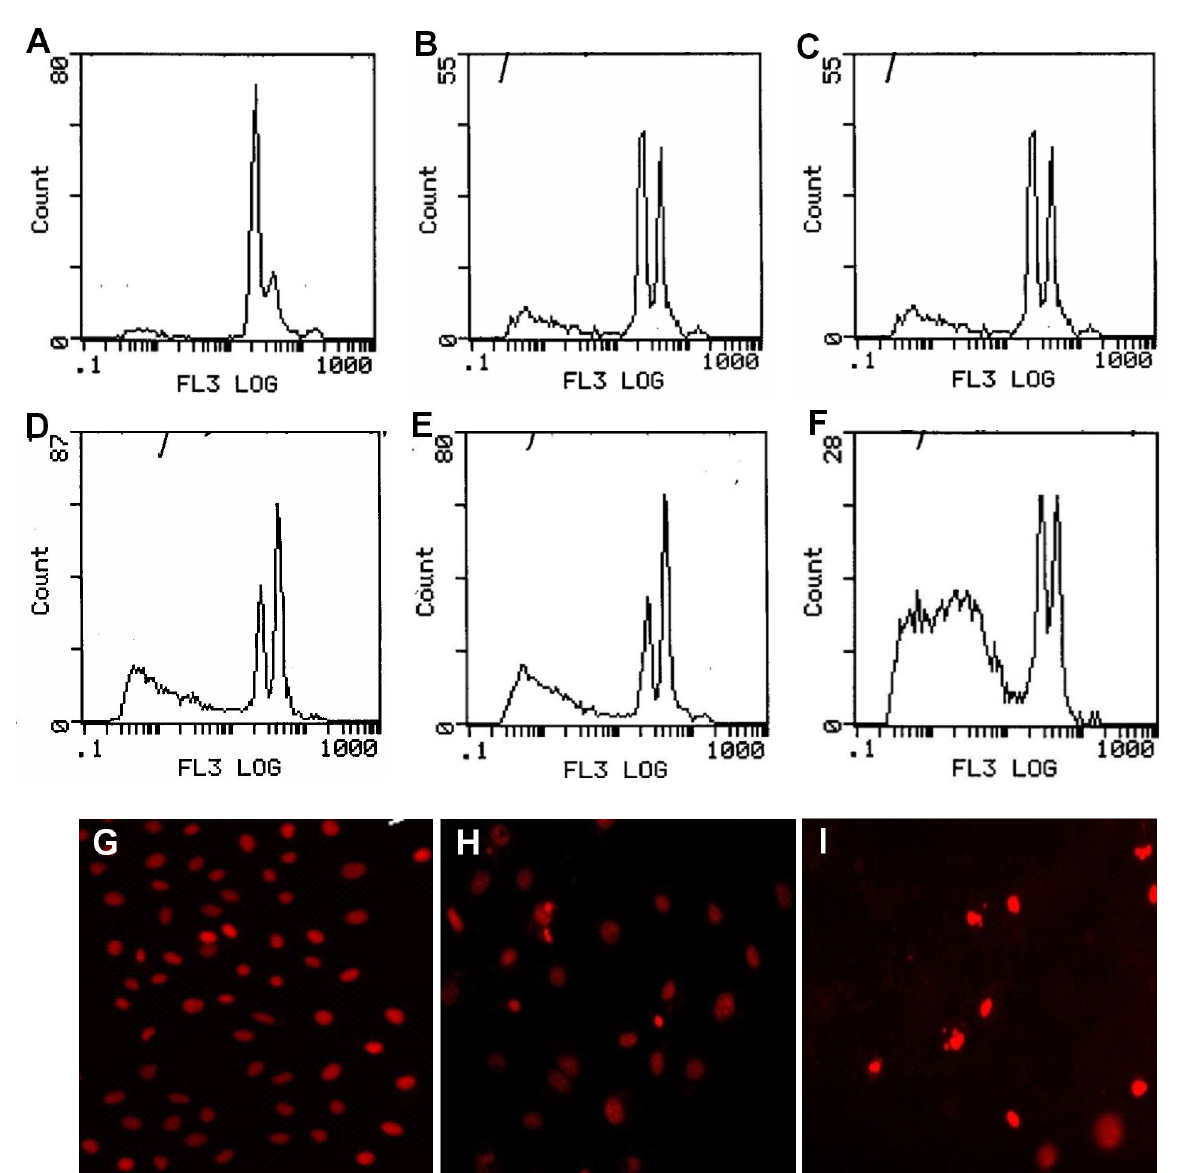
Figure 5. Revivification of RhoB gene and apoptosis of ovary carcinoma cells. Flow cytometric analysis (FCM) together with fluorescence microscopy was adopted to assess apoptosis of ovary carcinoma cells after treated with TSA. Top and middle panels : when cells were treated for 10 h with 0 µmol/L (control), 0.05 µmol/L, 0.1 µmol/L, 0.25 µmol/L, 0.5 µmol/L and 1.0 µmol/L of TSA, the apoptosis rate revealed by FCM was 9.5% (A), 26.9% (B), 28% (C), 41% (D), 45.9% (E) and 66.9% (F) respectively. Bottom panel : PI stained fluorescence photomicrographs of ovary carcinoma cells after treated with TSA. Cells were treated for 10h with 0 µmol/L (G, control), 0.1 µmol/L and 0.5 µmol/L of TSA respectively, both 0.1 µmol/L (H) and 0.5µmol/L (I) of TSA could result in cellular morphological changes characterized as apoptosis: a brightly red-fluorescent condensed nuclei (intact or fragmented), reduction of cell volume, and apoptotic bodies. doi: 10.1371/journal.pone.0078417.g005 Obstetrique (FIGO) guidelines [23] and classified in stage I-IV. followed-up after tumor resection to ensure collection of clinical All patients did not receive any neo-adjuvant treatment (neither data. chemotherapy nor radiotherapy) before surgical resection and